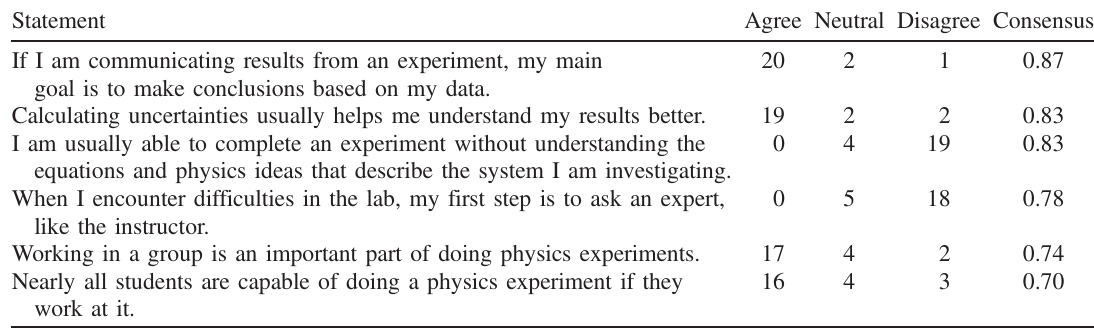
TABLE I. A list of E-CLASS statements with the faculty agreement less than 90%. Agree is the number of respondents who answered either “ Agree ” or “ Strongly Agree. ” Disagree is the number of respondents who answered either “ Disagree ” or “ Strongly Disagree. ” Consensus refers to the fraction of respondents in the consensus